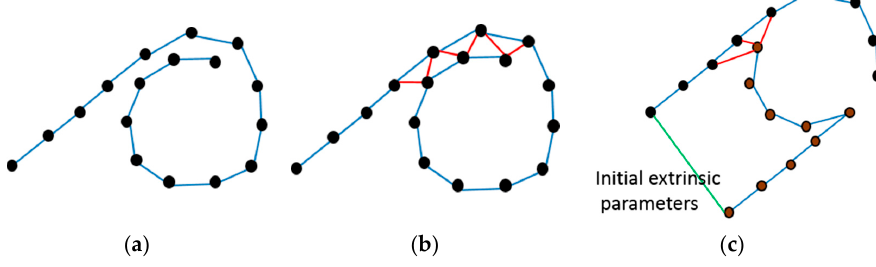
Figure 2. The sketch map of the pose graph. ( a ) is the initial pose graph obtained by VO where the blue edges are the transformations between two nearby keyframes. ( b ) is obtained after the closing loop detection and the red edges connect the frames satisfying the loop constraints. ( c ) denotes the relationship between two cameras, where black vertices are the poses of one camera and brown vertices belong to another camera, the green edge means the extrinsic parameters which can be initially set to the identity matrix.